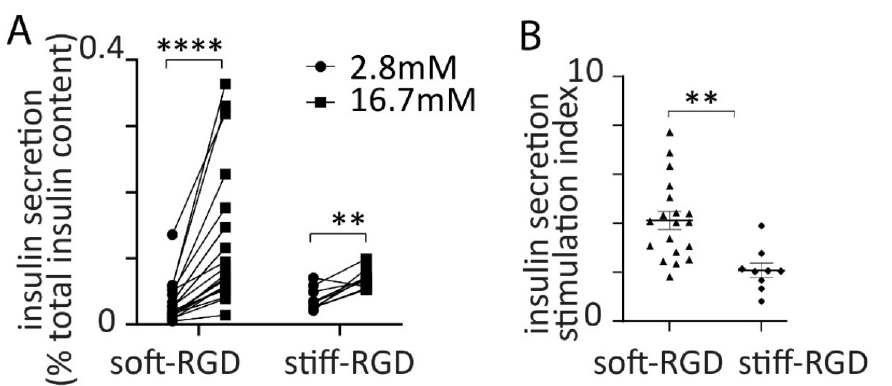
Figure 7. Effect of alginate stiffness on glucose-induced insulin secretion. ( A ) Spheroids were embedded in soft-RGD alginate or stiff-RGD alginate and then subjected to a stepped increase in glucose from 2.8 mM to 16.7 mM. This induced a significant increase in insulin secretion from spheroids both in the soft-RGD (n = 23 beads, Student t test p < 0.0001 -same data as in Figure 2A, **** p < 0.001) and in the stiff-RGD (n = 9 beads, Student t test p < 0.001). ( B ) A comparison of the insulin stimulation index (fold increase) in insulin secretion induced by high glucose showed an enhancement in softer alginate-RGD (Student t test p < 0.01, ** p <